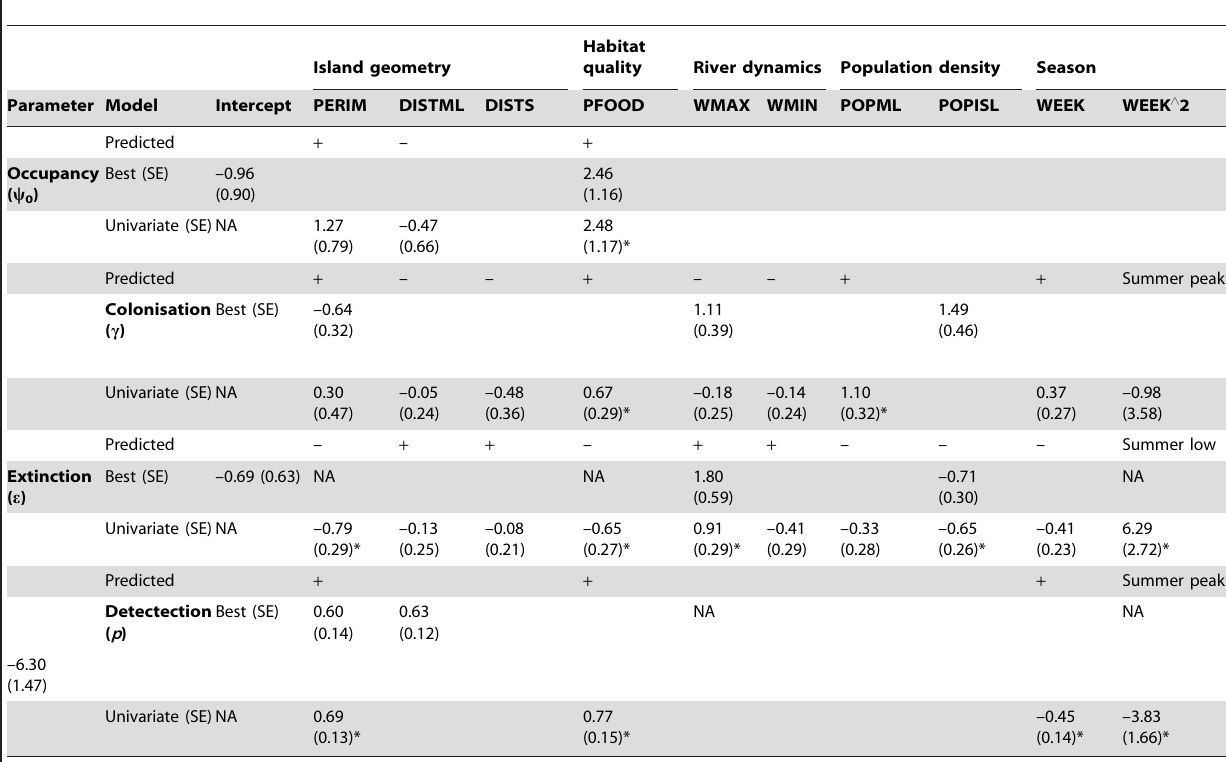
Table 2. Estimates 6 SE on the logit scale for the covariates used to model the occupancy dynamics ( y 0 , c , e , p ) of the root vole